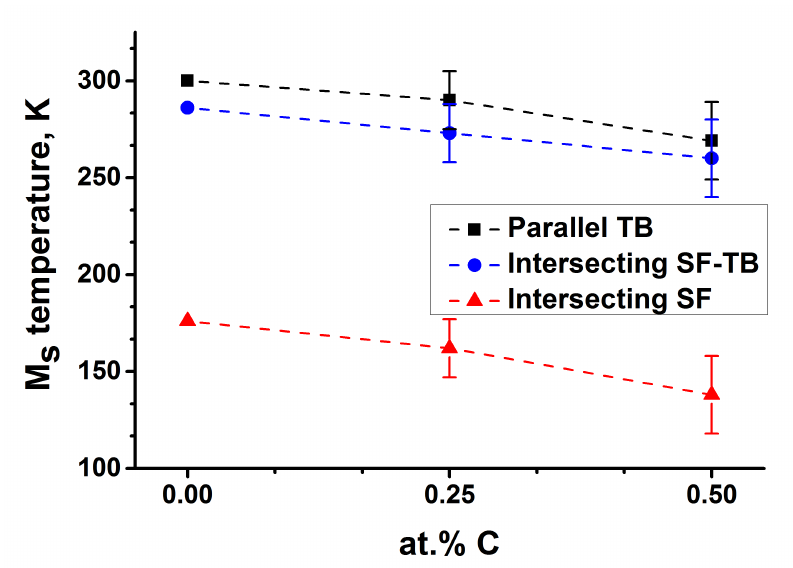
Figure 2. M s temperature as a function of C concentrations for fcc phase with three defect